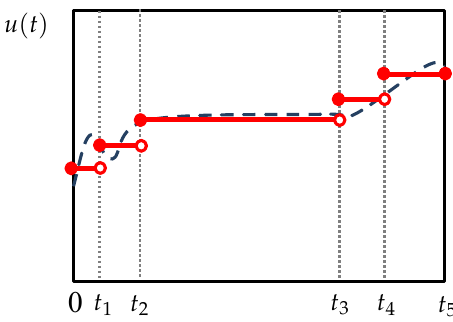
Figure 2. Schematic of an optimal control trajectory resulting from a nonuniform discretization. The dashed line illustrates the ideal optimal trajectory that might be obtained without discretization.